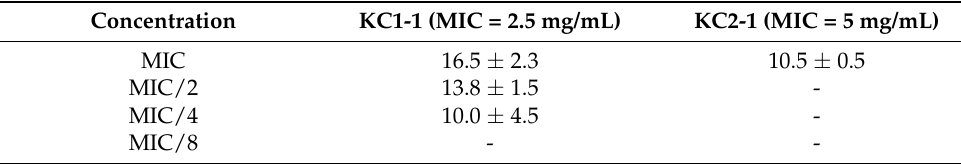
Table 4. Anti-quorum sensing activity zones (mm) on C. violaceum CV026.